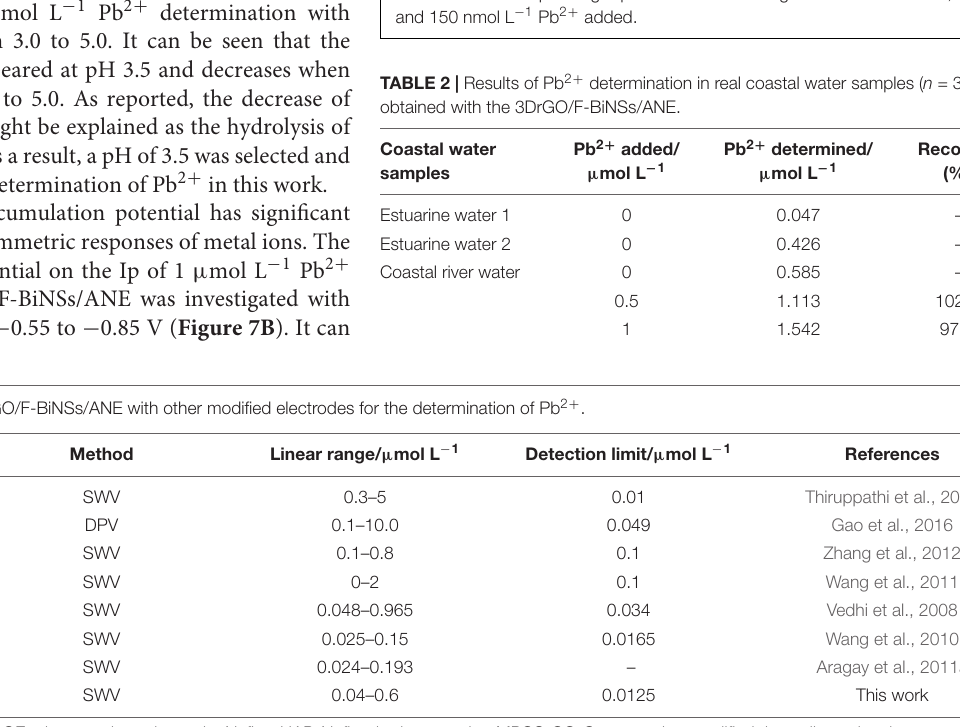
FIGURE 9 | Typical linear regression for the determination of Pb 2 + ( n = 3) in coastal water samples at 3DrGO/F-BiNSs/ANE by the standard addition